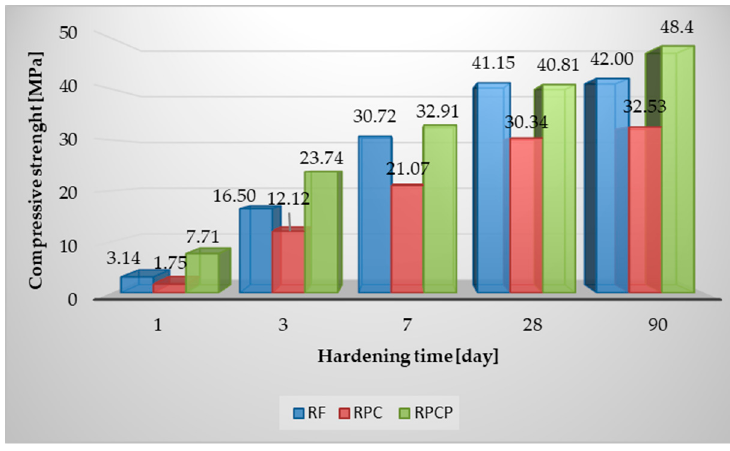
Figure 5. Compressive strength development of specimens up to 90 days.